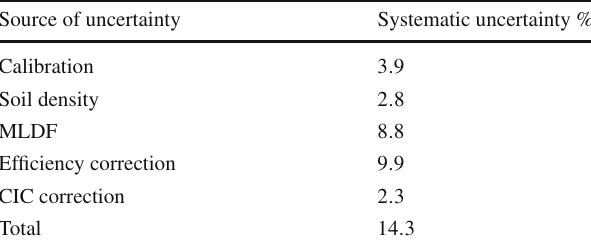
Table 1 Systematic uncertainties associated with the measurement of the muon density Source of uncertainty